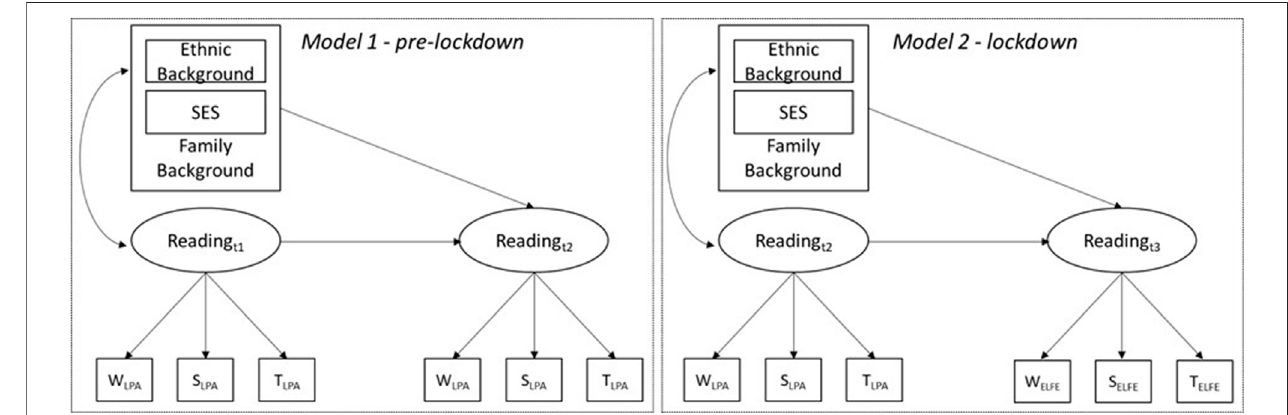
FIGURE 3 | SEM-Models for research question 1